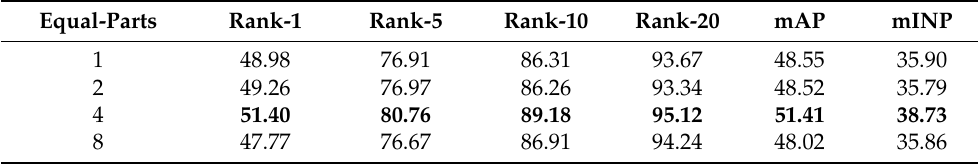
Table 6. Performance of different segmentation